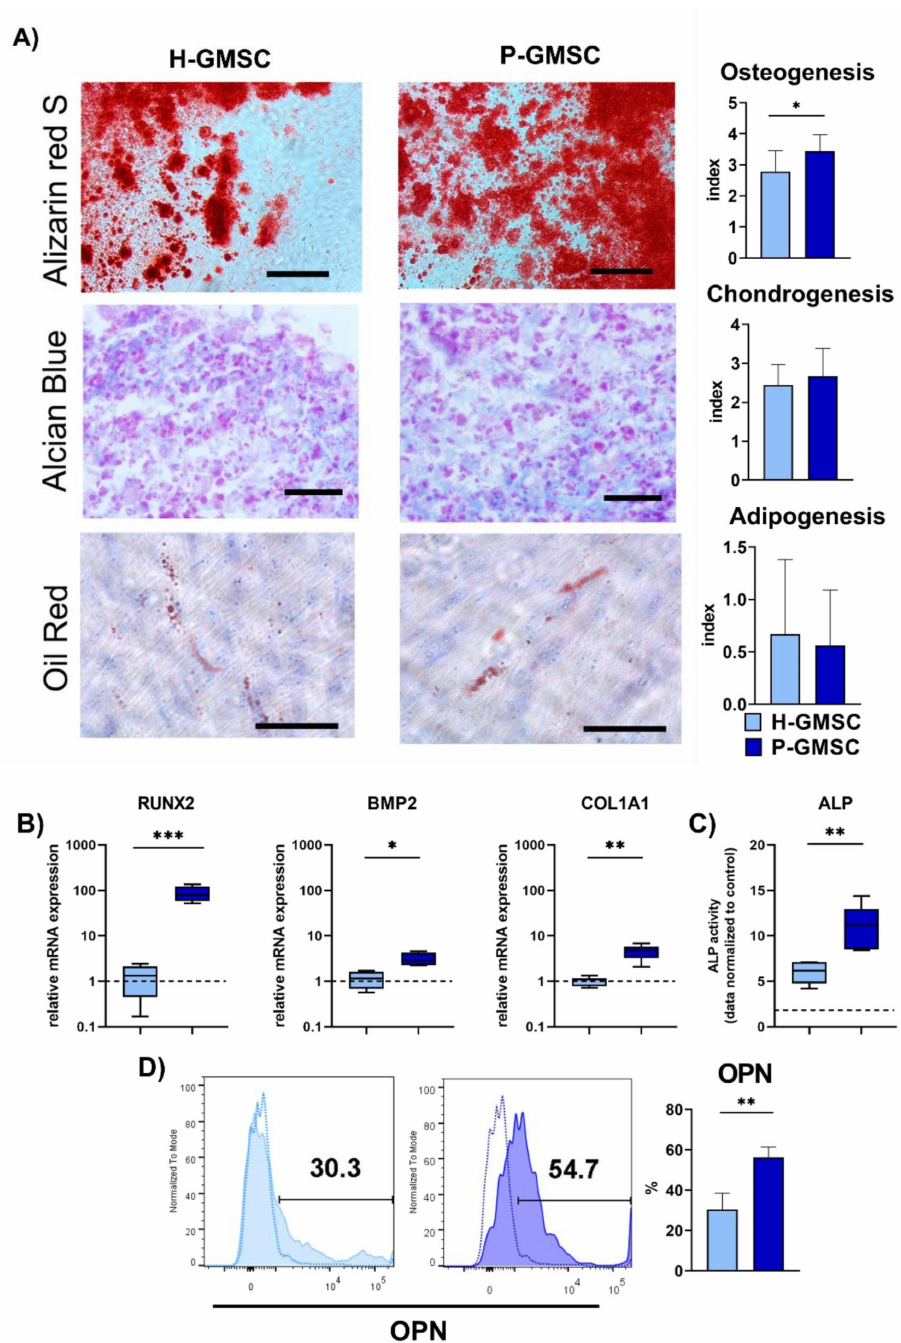
Figure 2. ( A ) Osteogenic (Alizarin red S staining), Chondrogenic (Alcian Blue staining) and Adi- pogenic (Oil Red staining) of H- and P-GMSC lines. Representative images of one (out of four) differentiation cultures are presented. Vertical columns represent differentiation indices (mean ± SD; n = 4). ( B ) RUNX2, BMP-2 and COL1A1 gene expression in H- and P-GMSC lines ( n = 3) differentiated in the osteogenic medium; ( C ) ALP activity in H- and P-GMSC lines ( n = 3) differentiated in the osteogenic medium; ( D ) Flow cytometric analysis of OPN expression in H- and P-GMSC lines differ- entiated in the osteogenic medium. In addition to the total values given for each group (mean ± SD; n = 3), representative histograms from one of each line are presented. The bars are placed according to the controls. *** p < 0.001; ** p < 0.01; * p < 0.05 between H- and P-GMSC